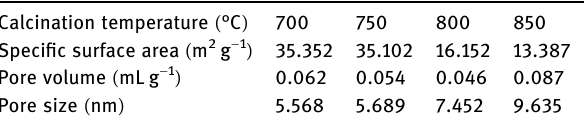
Table 1: Speci fi c surface area, pore volume, and pore size distri - bution of the Fe – Sn – O catalyst at di ff erent calcination temperatures Calcination temperature ( °C )